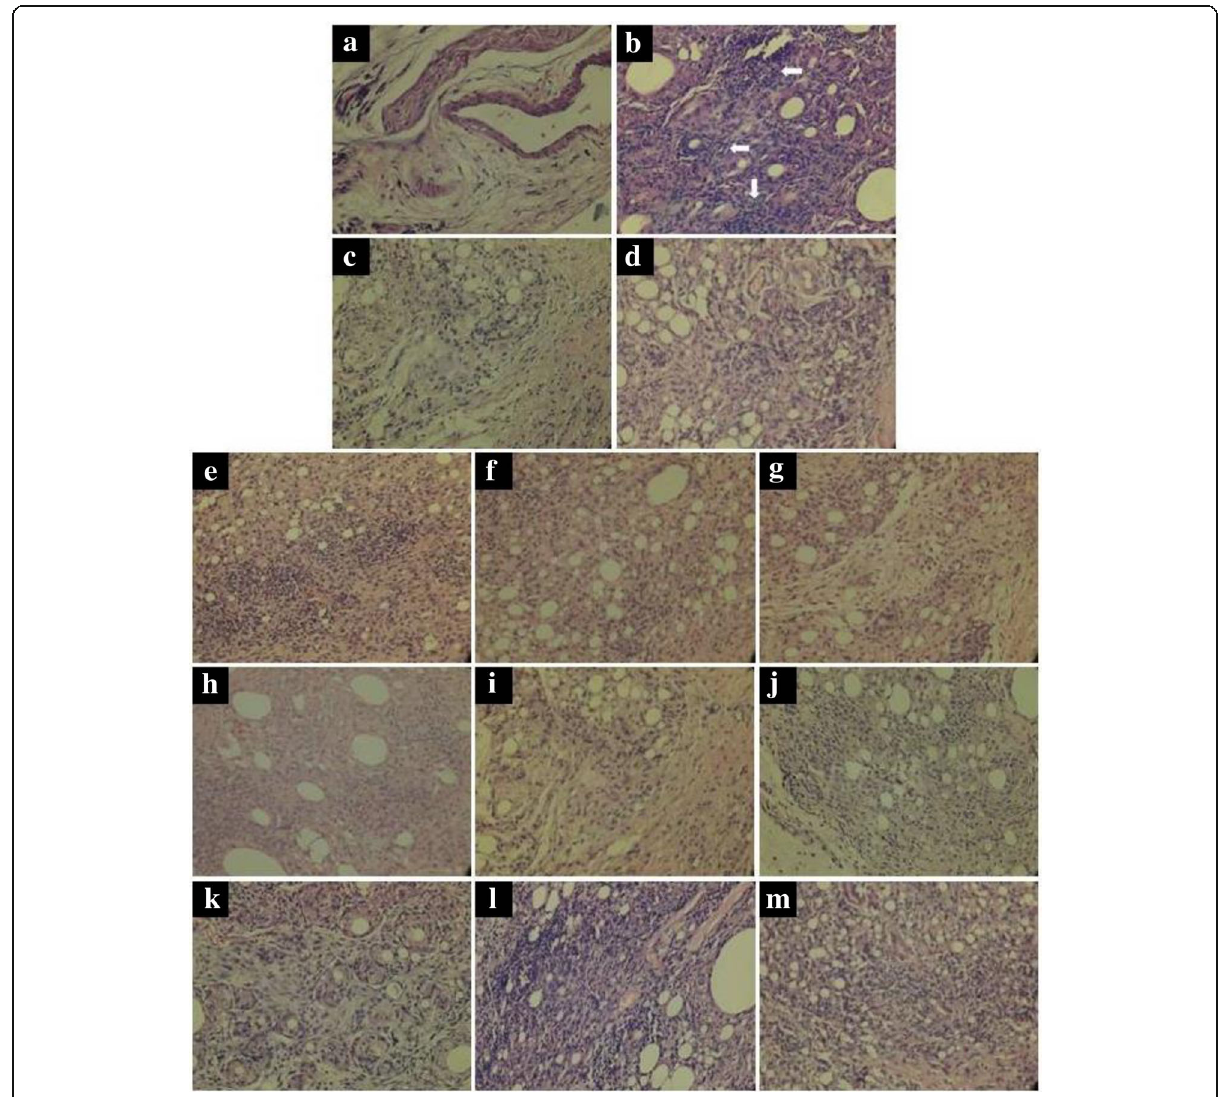
Fig. 3 Histological sections of paw tissues. Representative histological sections of paw tissues. Samples were harvested on 29th day after CFA injection. H&E staining (40X). a HC, b NC, c Diclo, d Dasha, e DF1911-LD, f DF1911-MD, g DF1911-HD, h DF2112-LD, i DF2112-MD, j DF2112-HD, k DF2813-LD, l DF2813-MD, m DF2813-HD. Normal appearance of paw tissue without any lesion seen in Figure ( a ). Extensive cellular infiltrations are seen in Figure ( b , j , k , l and m ). Mild cellular infiltrations are seen in Figure ( c , d , e , f , g , h and i ). (HC: Healthy control, NC: Negative control, Diclo: Diclofenac sodium, Dasha: Dashamoola Kwatha , DF: Dashamoola Formulation, LD: Lower dose, MD: Middle dose, HD: Higher